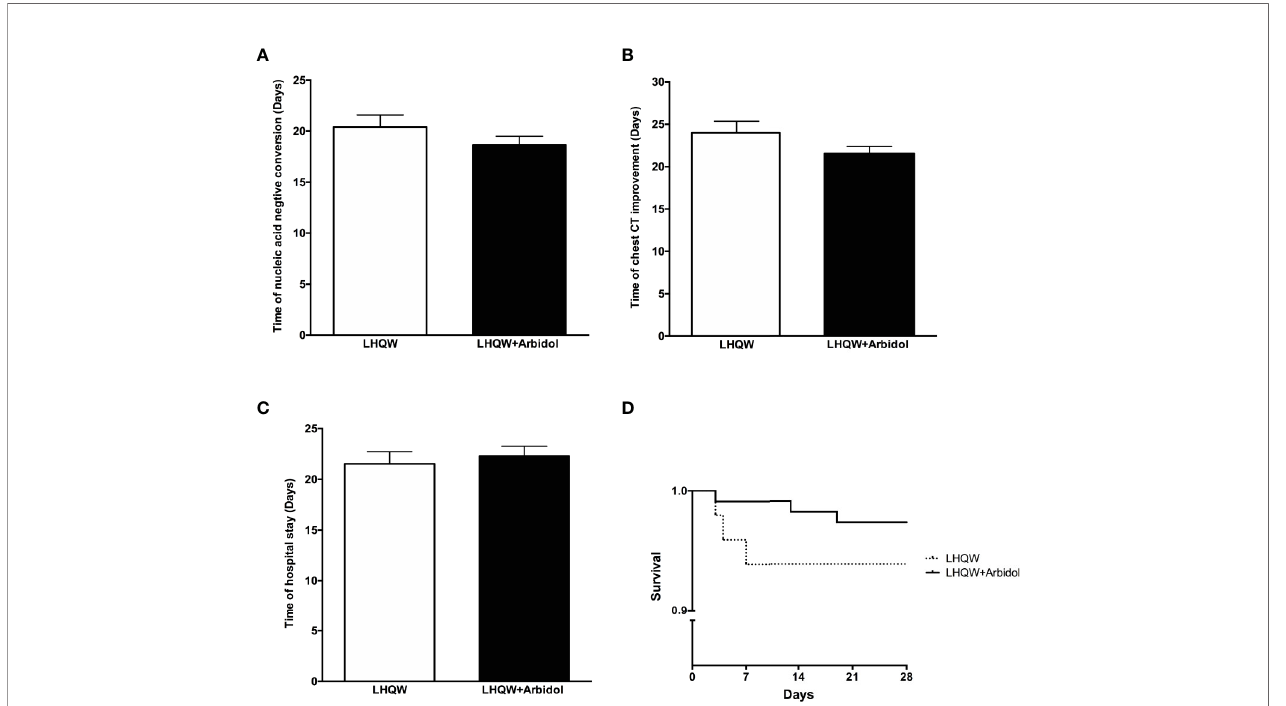
FIGURE 2 | Ef fi cacy of LHQW and LHQW + Arbidol treatment among all enrolled COVID-19 patients. (A) Effect on the time to conversion to nucleic acid negativity. (B) Effect on time to chest CT improvement. (C) Effect on length of hospital stay. (D) Comparison of Kaplan – Meier survival curves of LHQW and LHQW + Arbidol treatment in all enrolled COVID-19